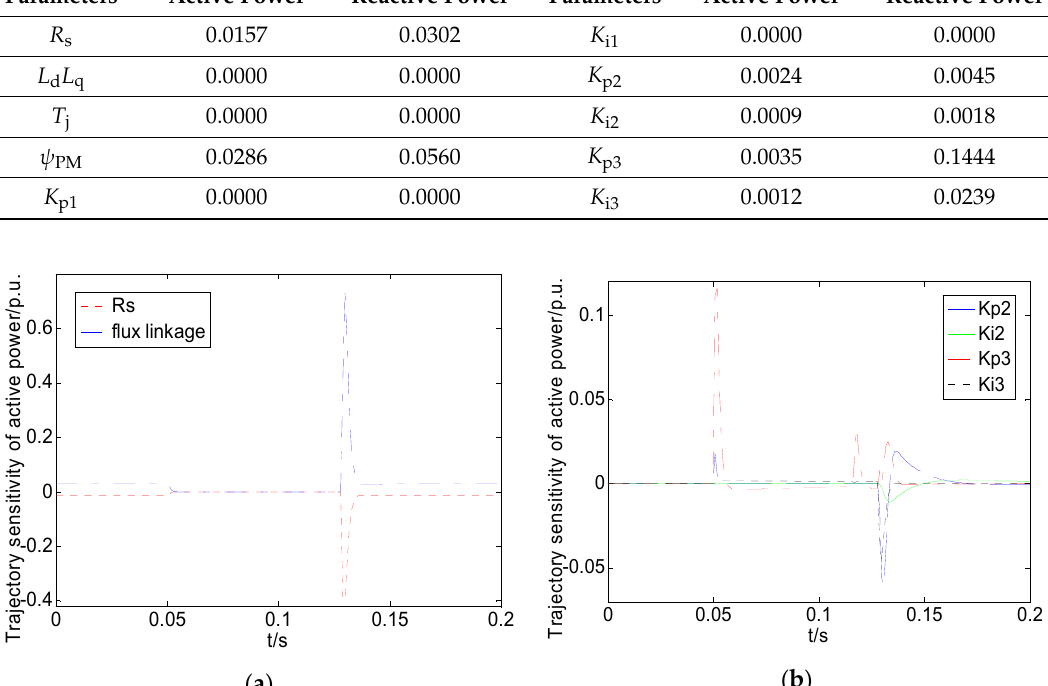
Figure 2. Trajectory sensitivity of active power when voltage dips about 30%: ( a ) Trajectory sensitivity of active power for R s and ψ PM ; ( b ) Trajectory sensitivity of active power for K p2 , K i2 , K p3 and K i3 .